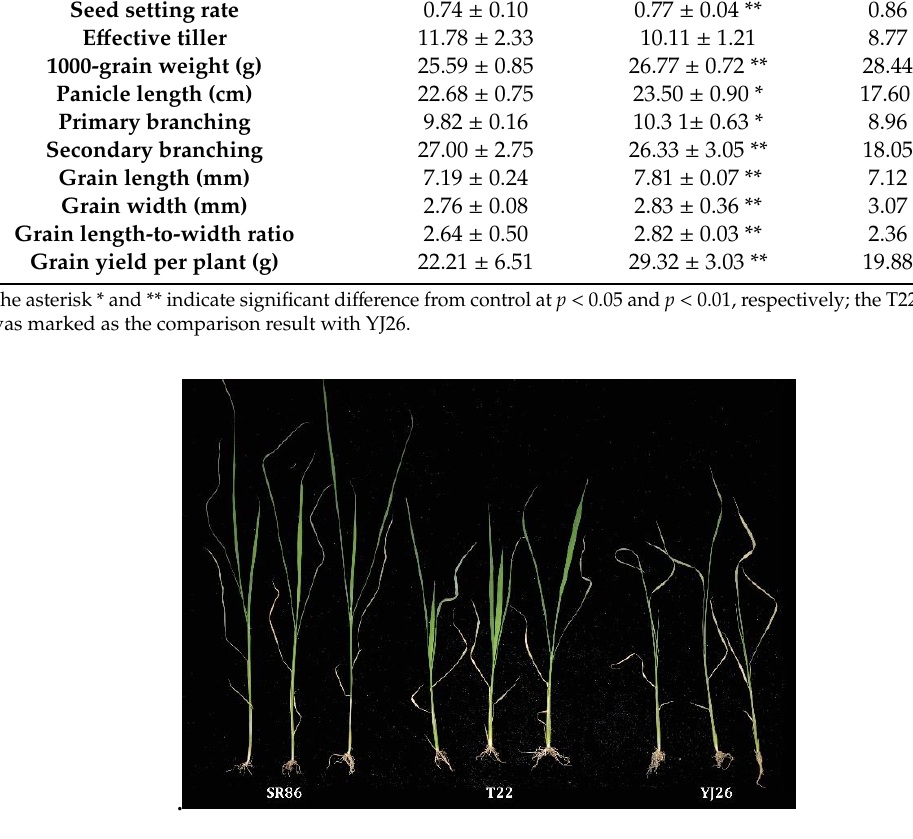
Figure 3. Identification of salt tolerance in IL-T22. It shows the salt resistance of T22 was similar or even better than SR86 compared to YJ26 after being treated with 1.2% NaCl solution for 8 d. Table 3. Results of agronomic traits in infiltrated lines and two parents under normal field conditions. Traits